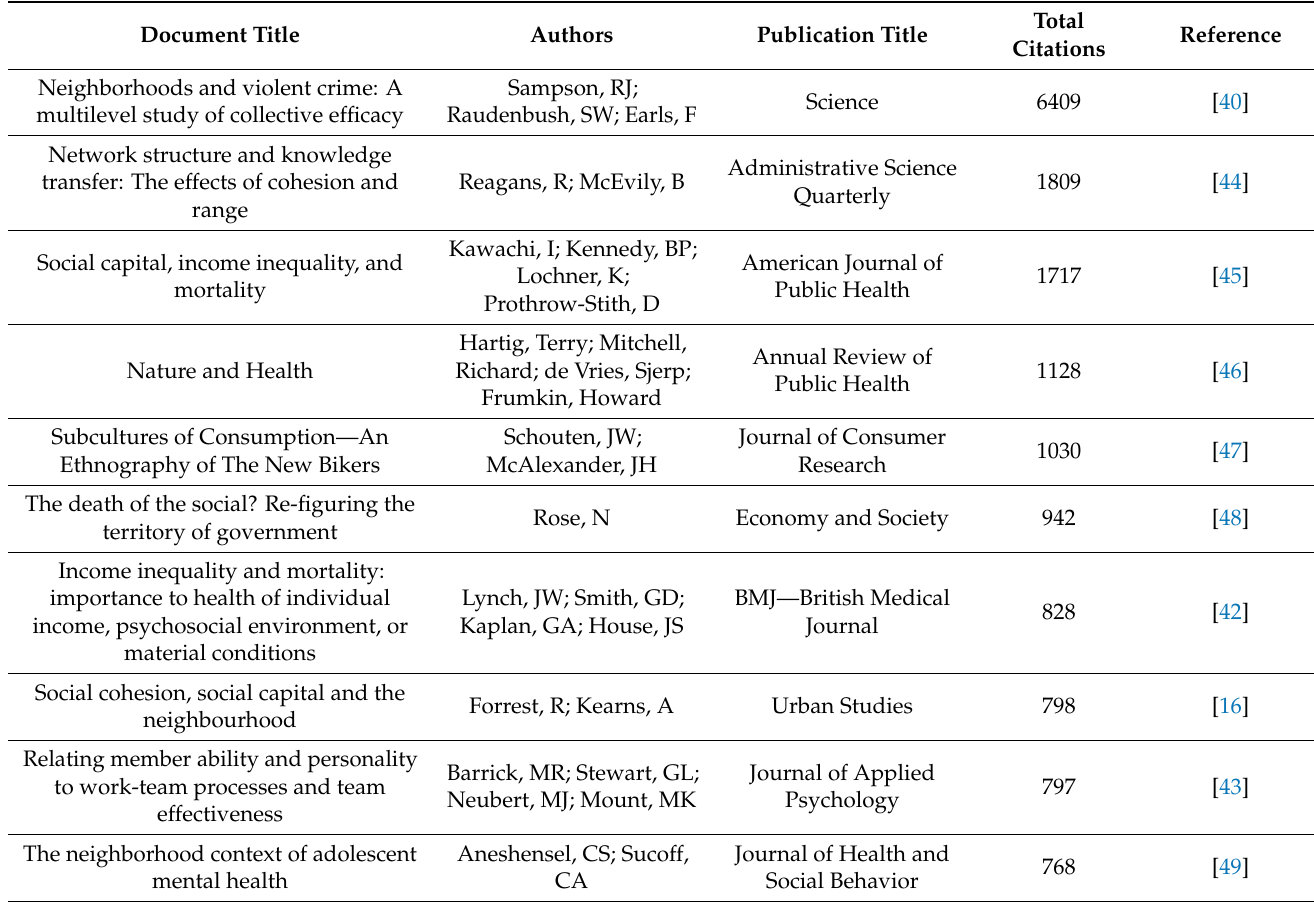
Table 4. Top 10 most cited documents on “social